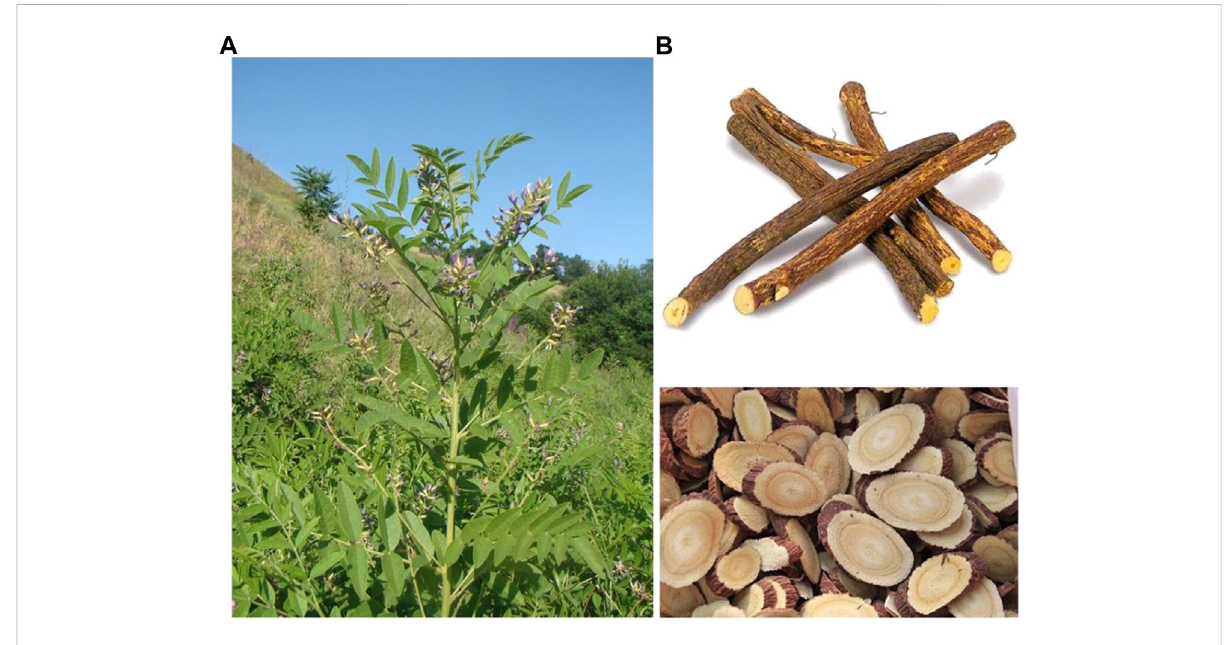
FIGURE 1 Pictures of licorice. (A) Glycyrrhiza ; (B) Licorice.